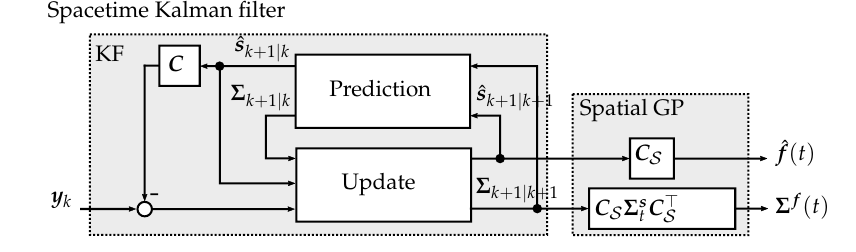
Figure 8. Block diagram of the spacetime Kalman